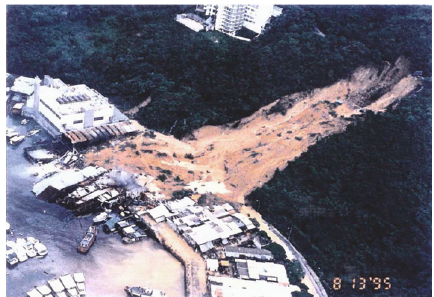
Figure 1: The Shum Wan Road landslide on August 13 1995